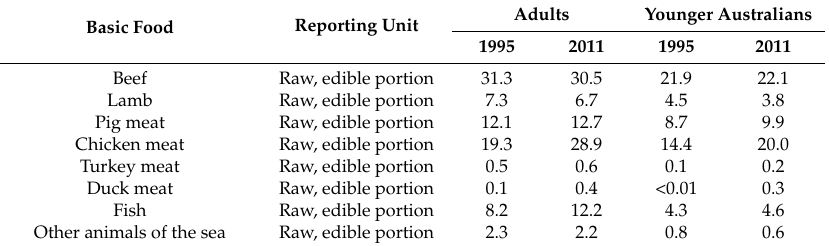
Table 4. Reported intake of meat and seafood (kg/person/year) by adult (19 years and above) and younger Australians (2 to 18 years) in 1995 and 2011.